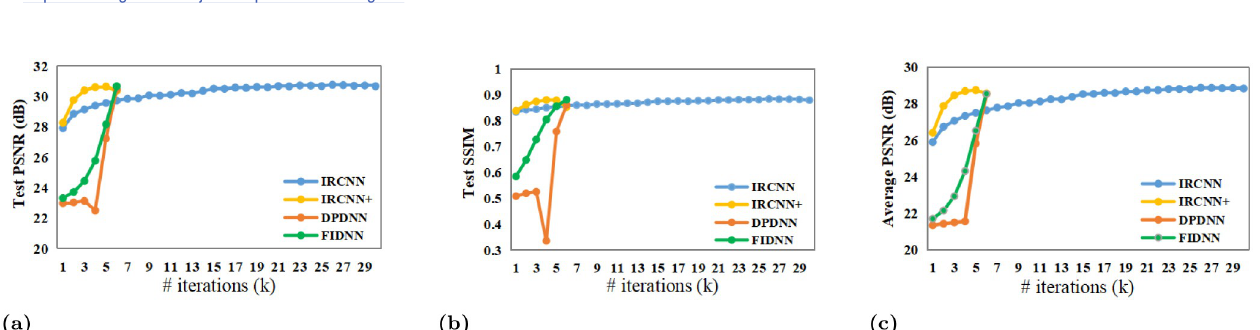
Fig 9. Gray deblurring results and parameter variations on each iteration for motion blur with kernel size 19 on ‘House’ image from Set10 dataset. (a) x1 (25.48). (b) x2 (26.43). (c) x3 (27.01). (d) x4 (28.62). (e) x5 (30.99). (f) x6 (32.06).